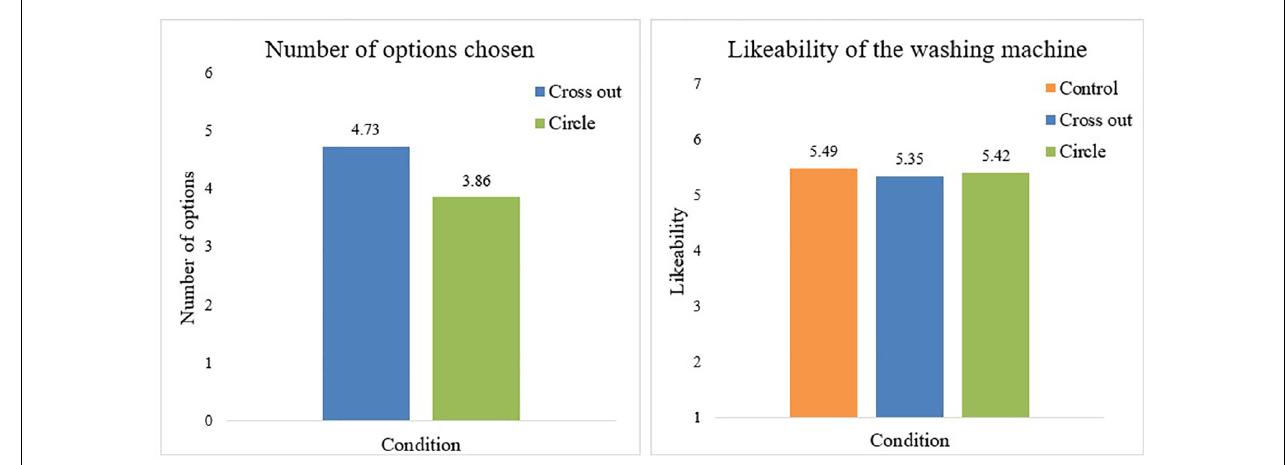
FIGURE 2 | The mean number of options chosen and likeability of the washing machine per